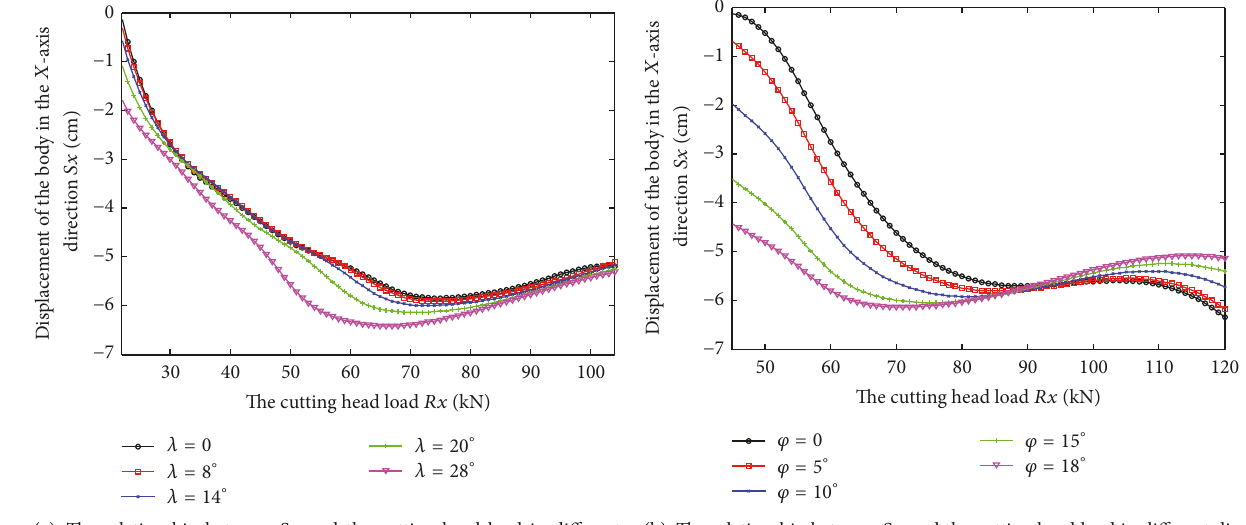
(a) The relationship between 𝑆 𝑋 and the cutting head load in different horizontal swing angles of the cutting arm